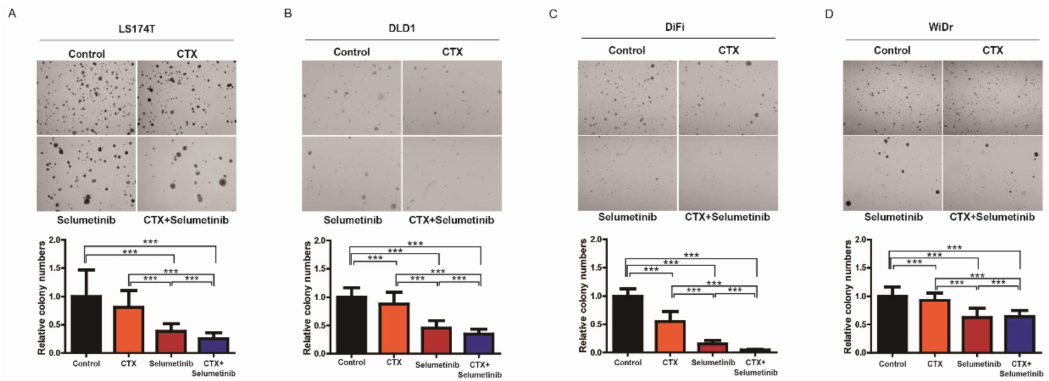
Figure 5. Combinatorial targeting of both EGFR and MAP kinase signaling pathways show synergistic e ff ects against colorectal cancer cell lines. ( A – D ) Colony formation assay was performed with LS174T ( A ), DLD1 ( B ), DiFi ( C ) and WiDr ( D ) cells following treatment with either CTX (50 µ g / mL or 10 µ g / mL for DiFi) or selumetinib (0.1 µ M) or together. The bar graph depicts the relative number of